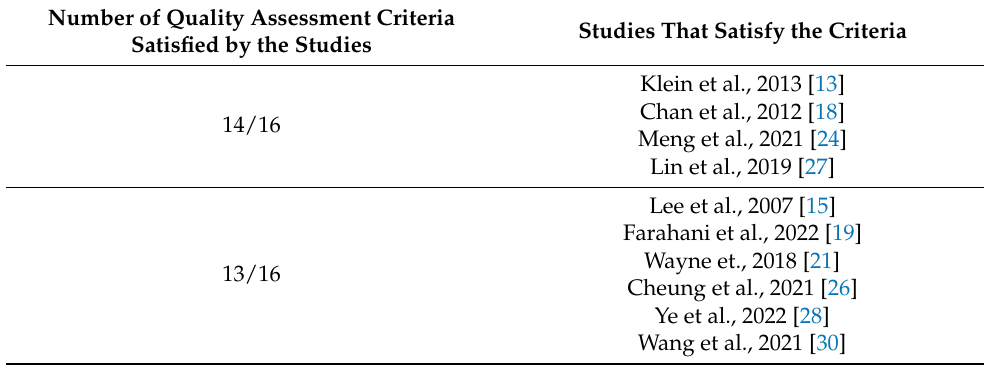
Table 2. Level of satisfaction of the 16 criteria required by AMSTAR2 quality assessment. Number of Quality Assessment